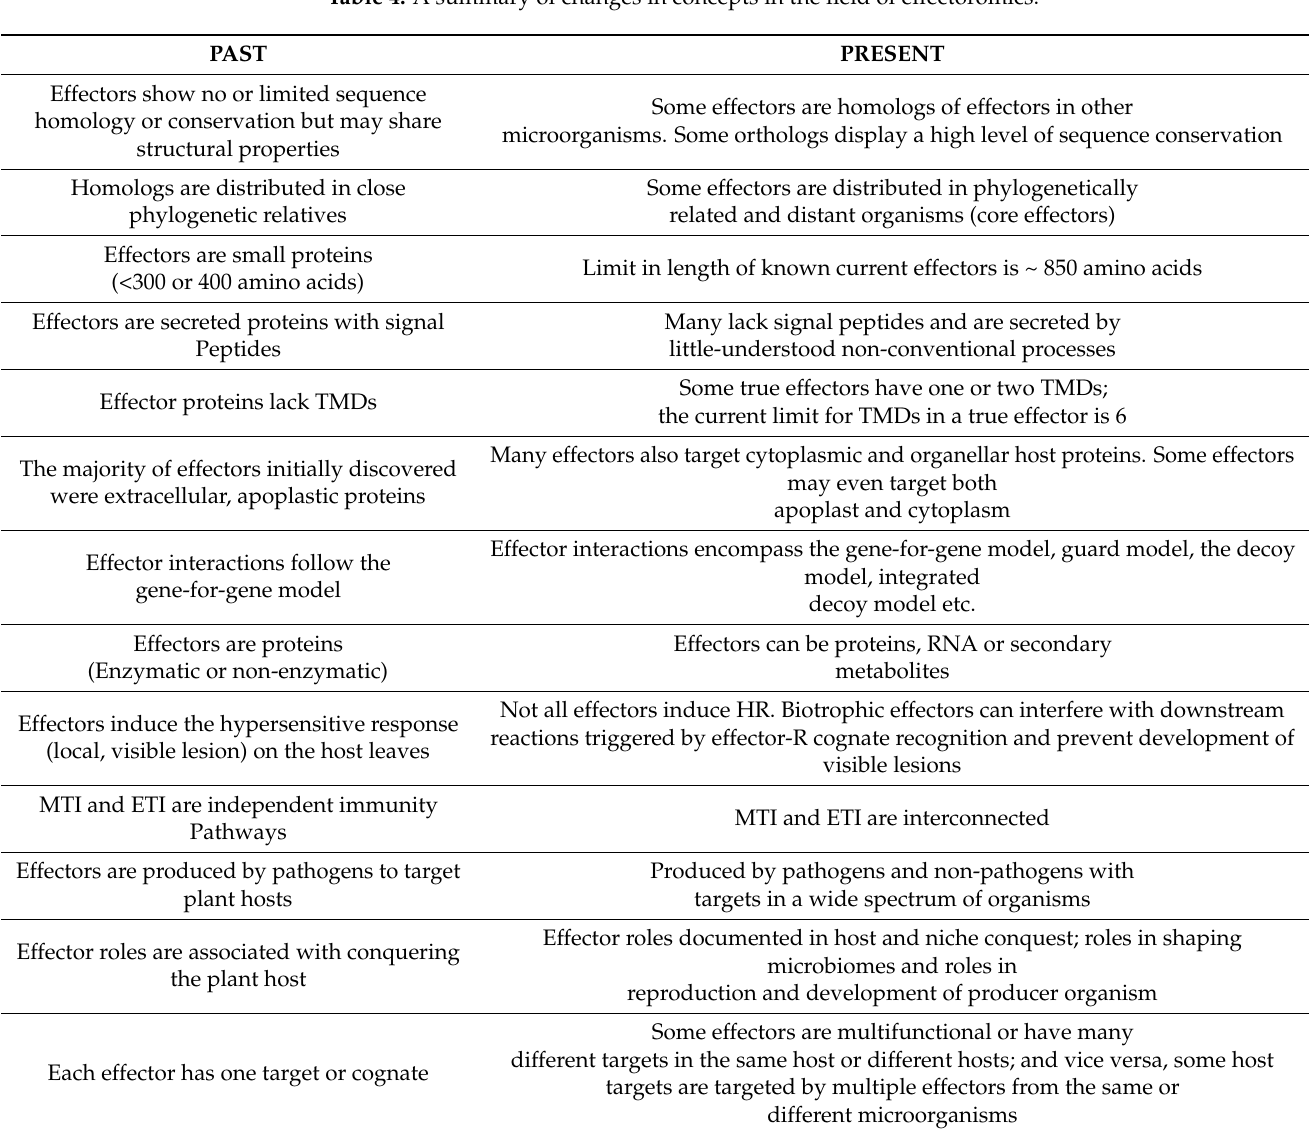
Table 4. A summary of changes in concepts in the field of